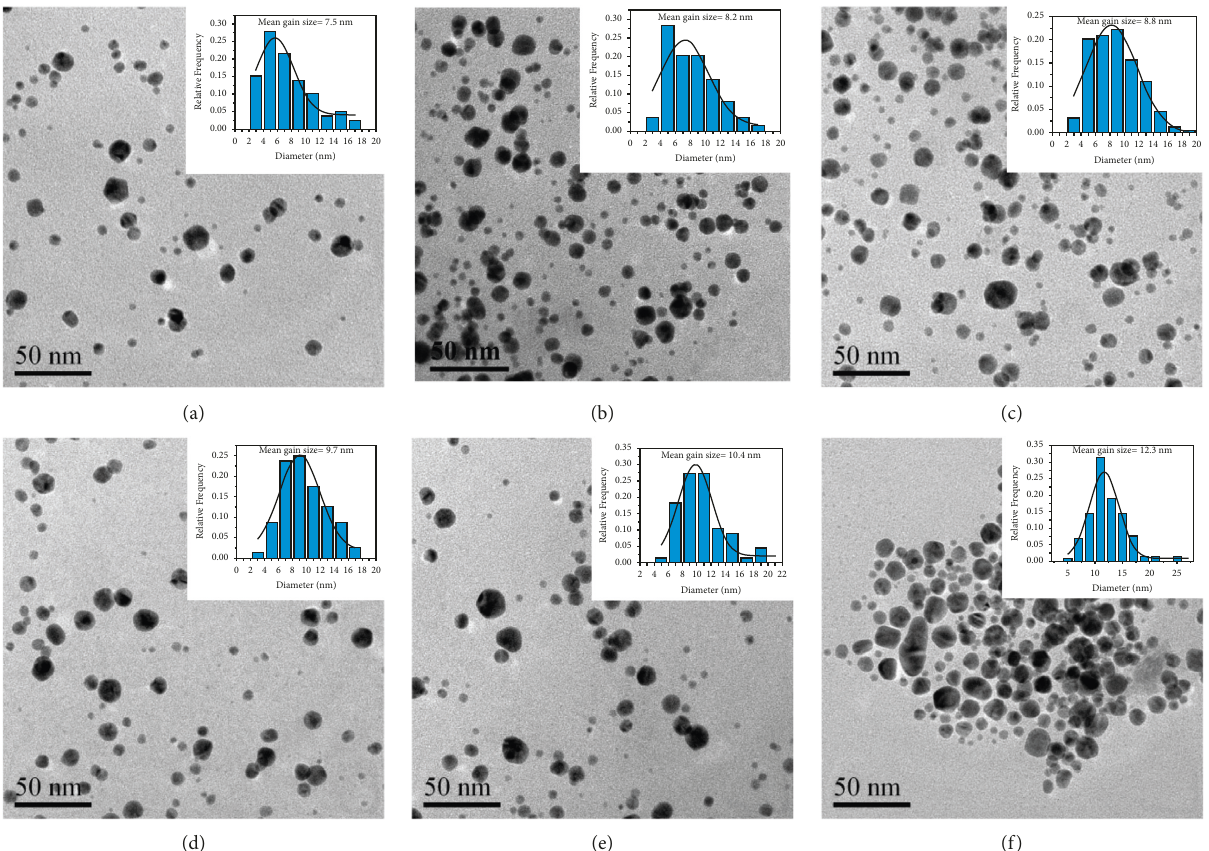
Figure 6: TEM images and frequency histograms of AuNP mixtures with different concentrations (a–f) Adulterant concentrations of 0%, 1%, 2%, 5%, 10%, and 20%,